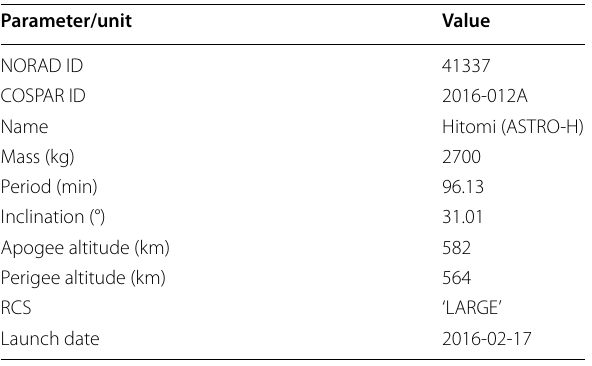
Table 2 Hitomi satellite information from JAXA (2016) and orbit data from USSTRATCOM’s Satellite Situation Report (SSR) retrieved on 6 May 2016